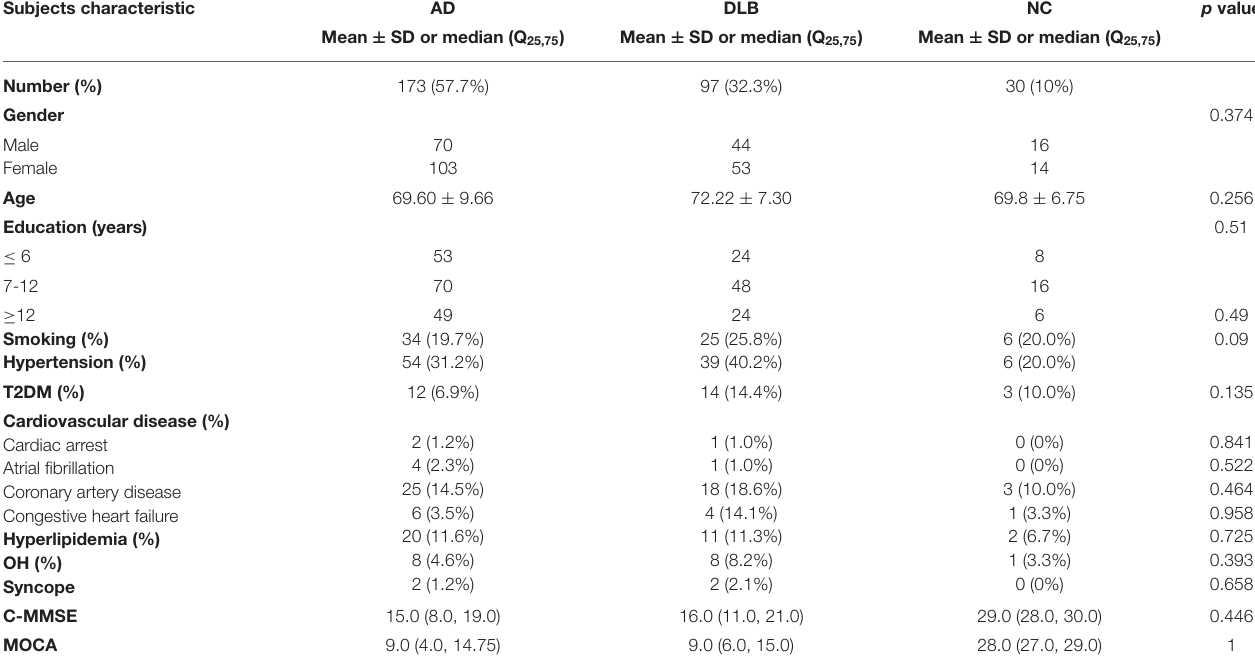
TABLE 1 | General clinical characteristics of each subject group.